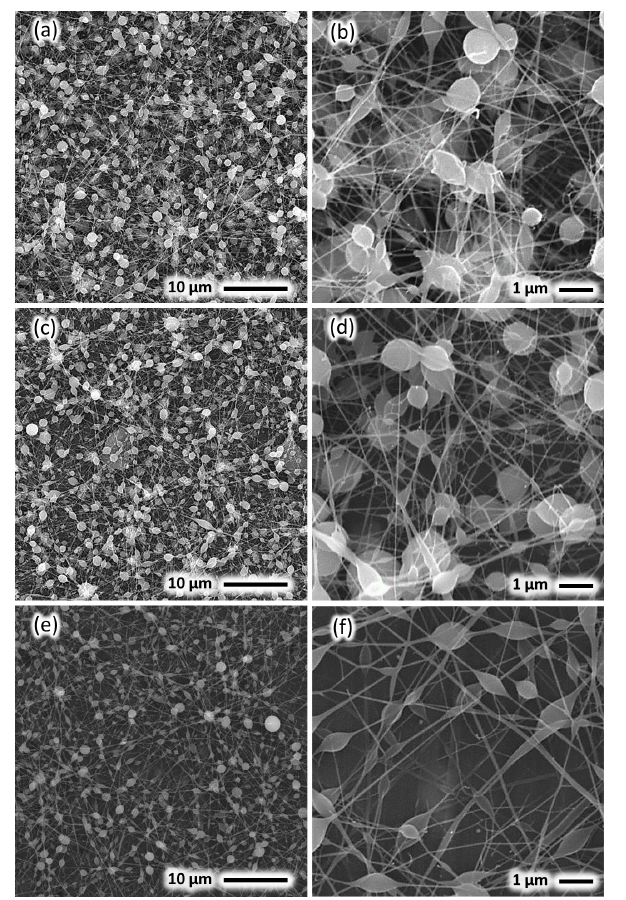
Figure 3. SEM image of the PEDOT–PSS/PVA nanofiber QCM with different magnifications: (a, b) QCM NF 1, (c, d) QCM NF 2, and (e, f) QCM NF